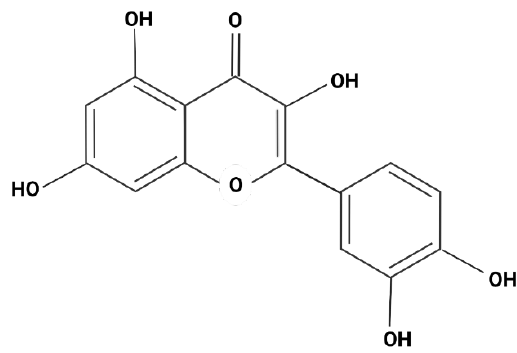
Figure 2. Molecular structure of quercetin.